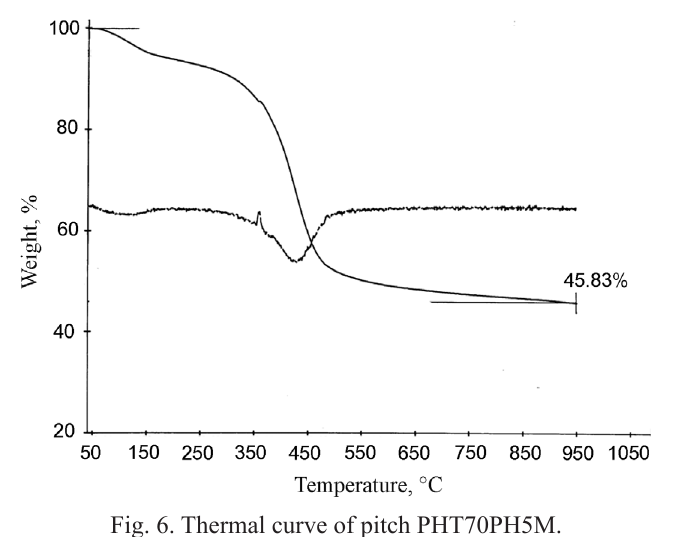
Fig. 6. Thermal curve of pitch PHT70PH5M.